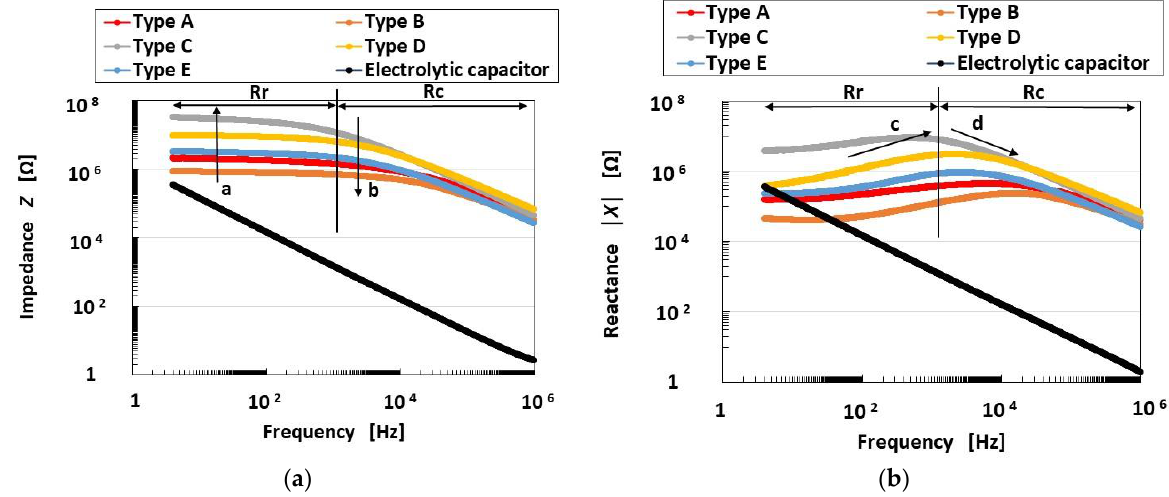
Figure 2. Impedance and reactance of the mechanoreceptors: ( a ) impedance; ( b ) reactance.